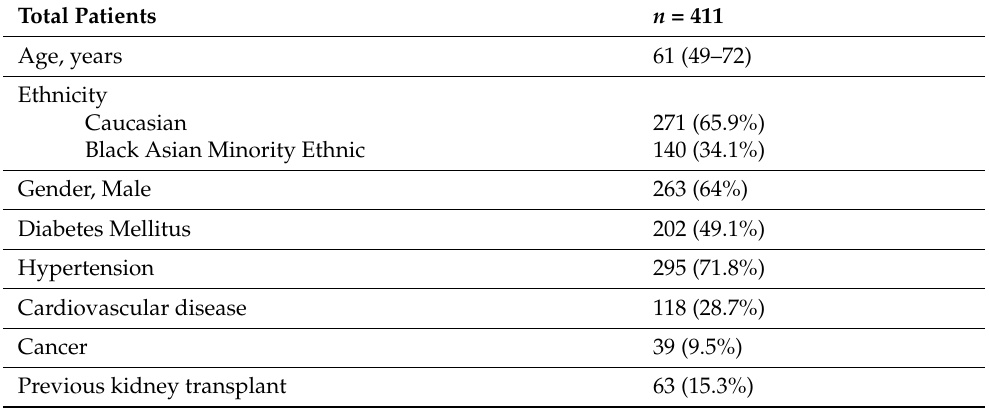
Table 1. Baseline characteristics of the sample population in January